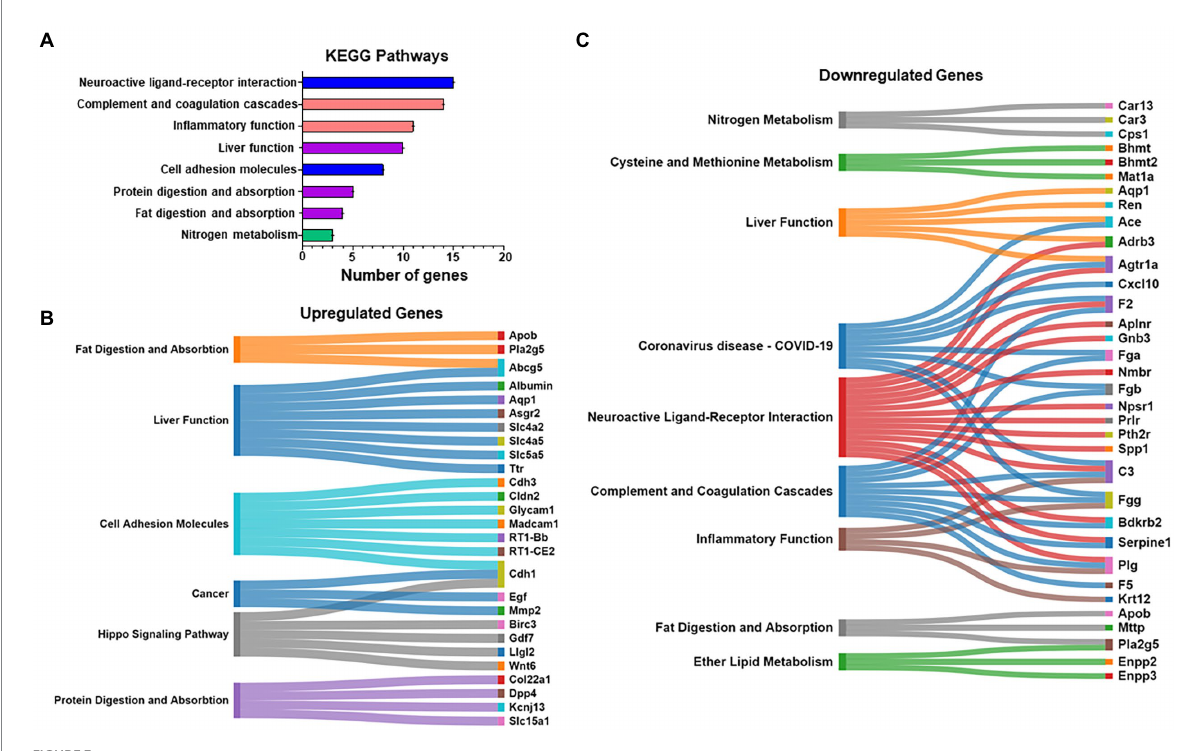
FIGURE 3 (A) Kyoto Encyclopedia of Genes and Genomes (KEGG) pathway analysis was also performed on the DEGs of all the eight pair-wise comparisons similar to the Heatmap in Figure 2L. A pathway prominently highlighted was cell adhesion molecules (CAMs). (B,C) The list of mapped genes included in the above KEGG pathways is represented as Sankey diagrams (Sankomatic.com) that display overlap of up- (B) and downregulated (C) genes involved in shared and unique KEGG